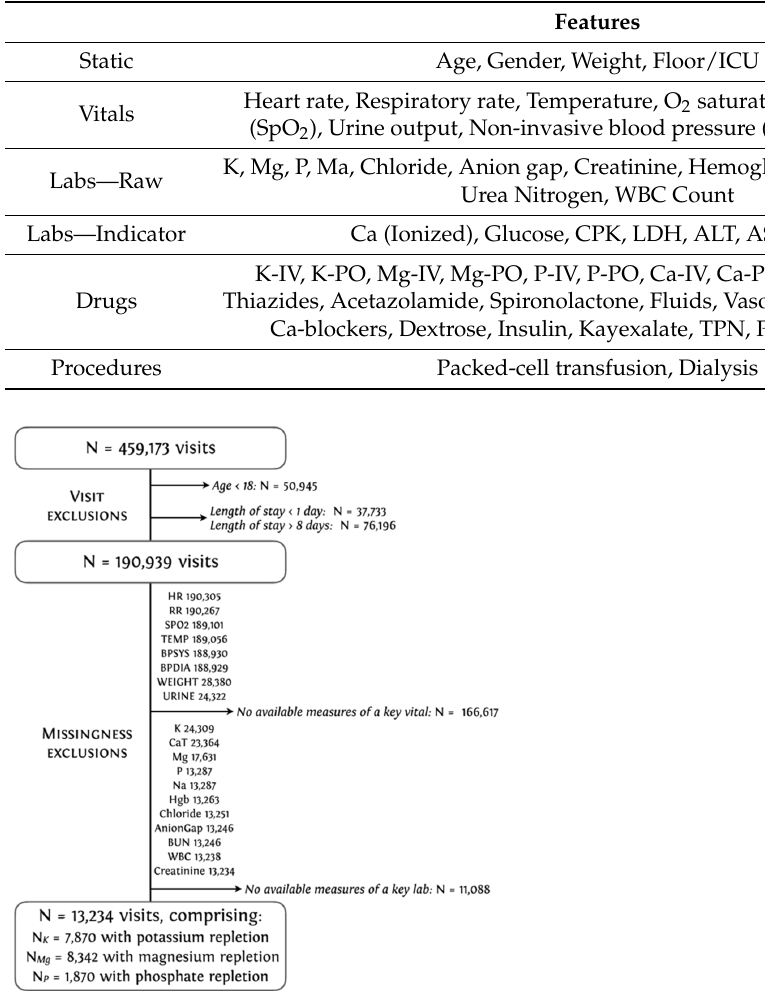
Figure 1. Data cohort selection criteria (demonstrated in the UPHS database). Heart rate, (HR); Respiratory rate, (RR); Oxygen saturation, (SPO 2 ); Temperature, (TEMP); Systolic blood pressure (BPSYS); Diastolic blood pressure, (BPDIA).